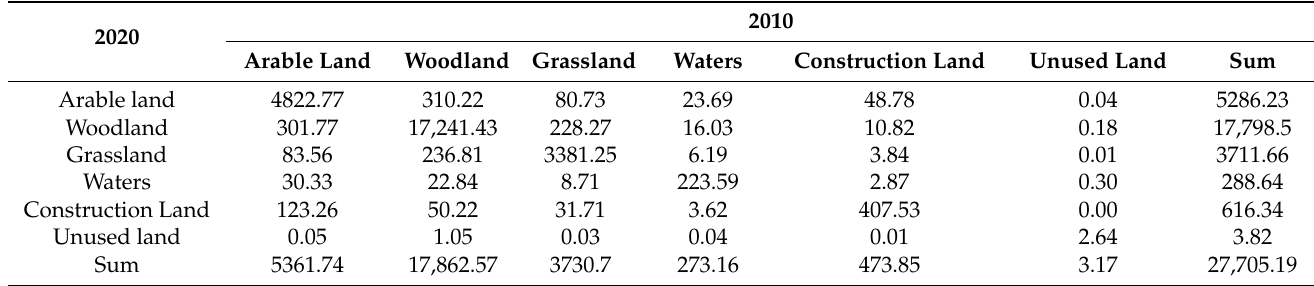
Table 4. Land-use type transfer matrix in Guilin from 2010 to 2020 (unit: km 2